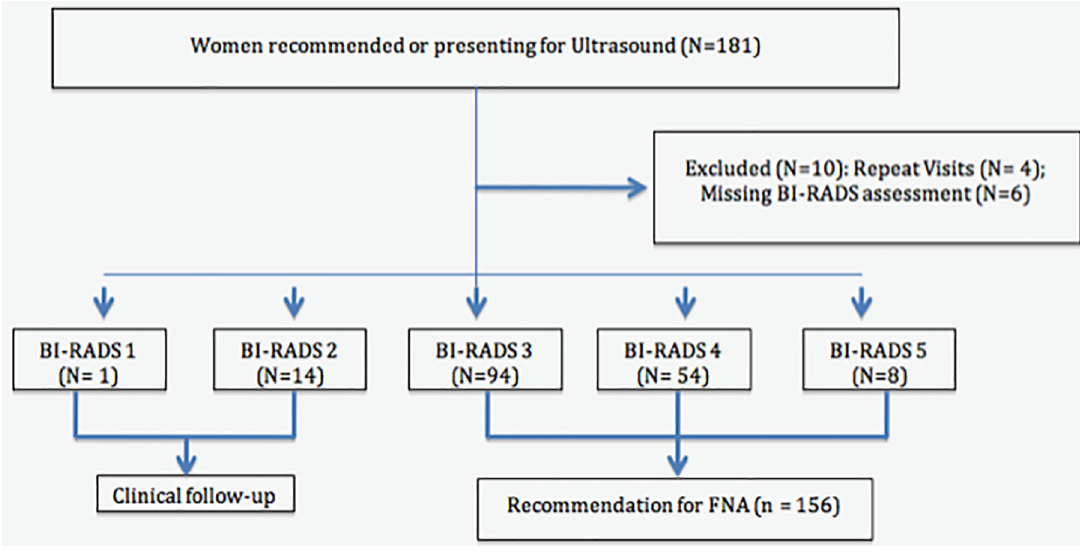
Fig 1. Flowchart for ultrasound examination